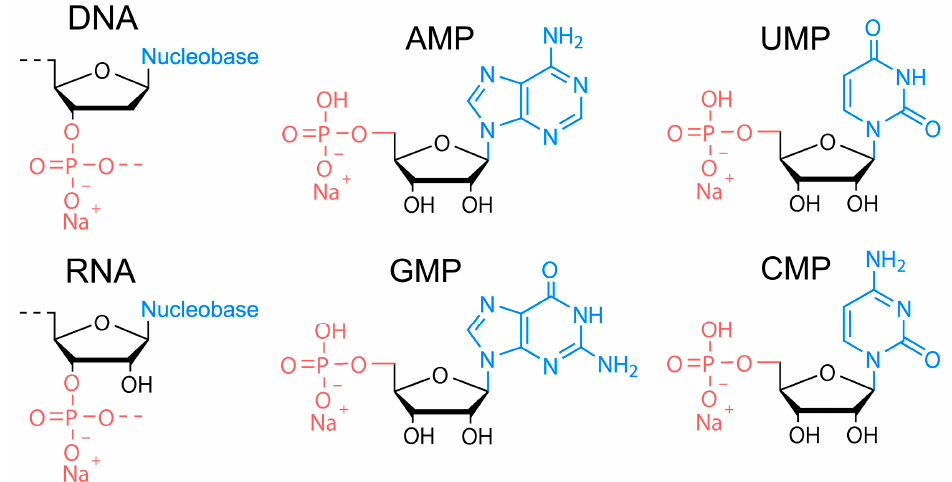
Figure 1. Chemical structures of nucleic acids used as precursors for synthesis of biodots. Chemical structure of DNA, RNA, sodium adenosine monophosphate (AMP), sodium uridine monophosphate (UMP), sodium guanidine monophosphate (GMP), and sodium cytosine monophosphate